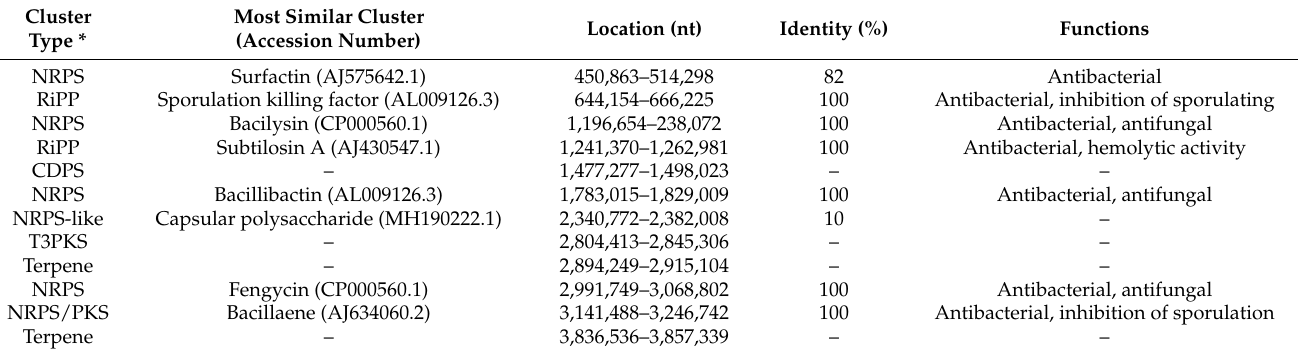
Table 2. Identified biosynthetic gene clusters of secondary metabolites in B . subtilis IDCC1101 using